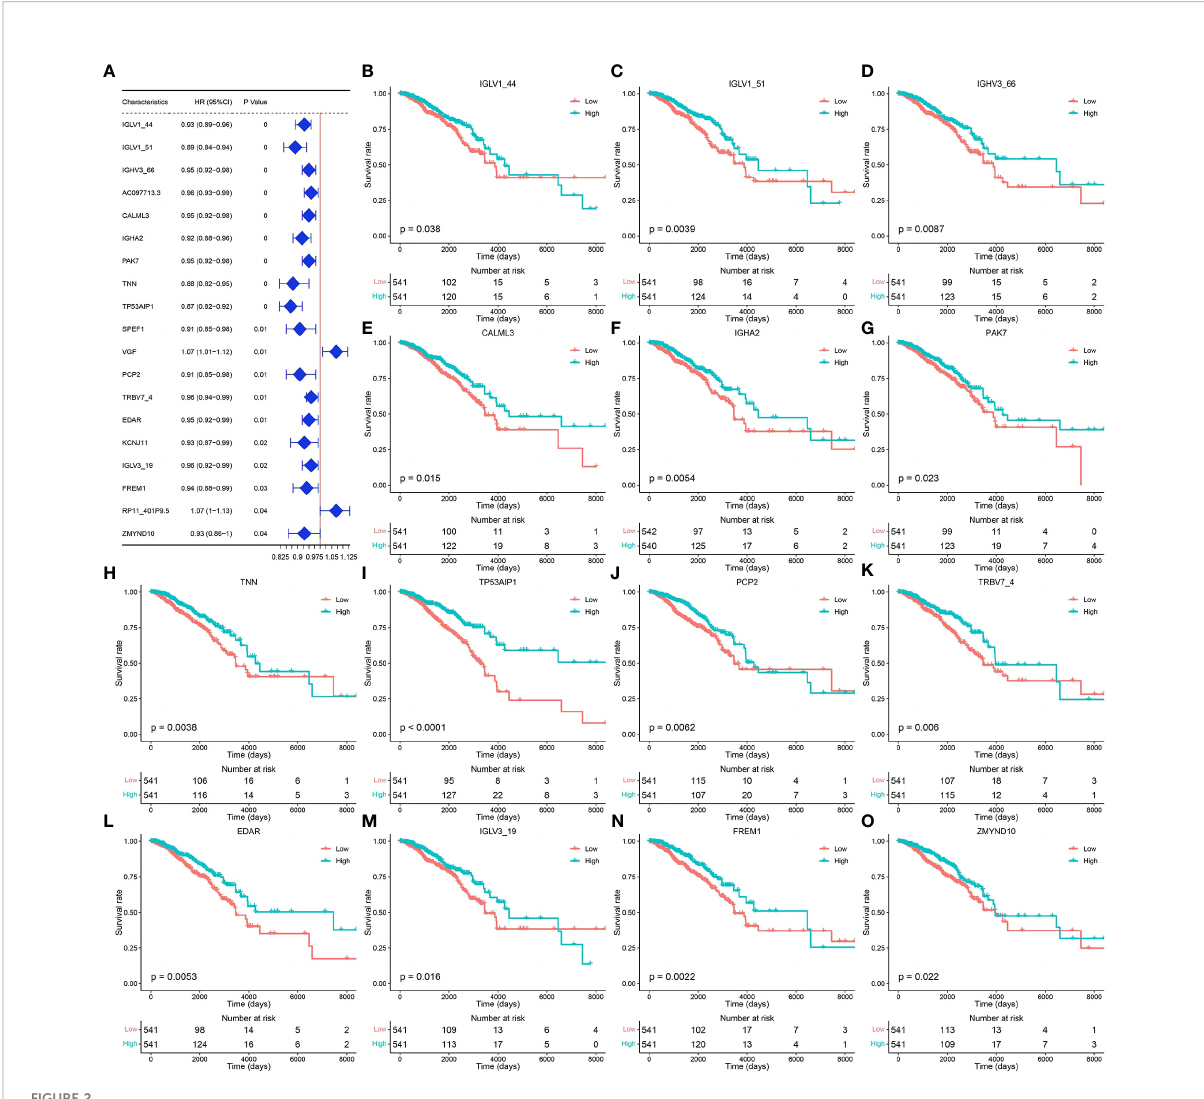
FIGURE 2 Genes related to the prognosis of breast cancer. (A) Results of univariate Cox analysis of the TCGA-BRCA dataset. (B – O) Prognosis-related pyroptosis gene expression and breast cancer survival